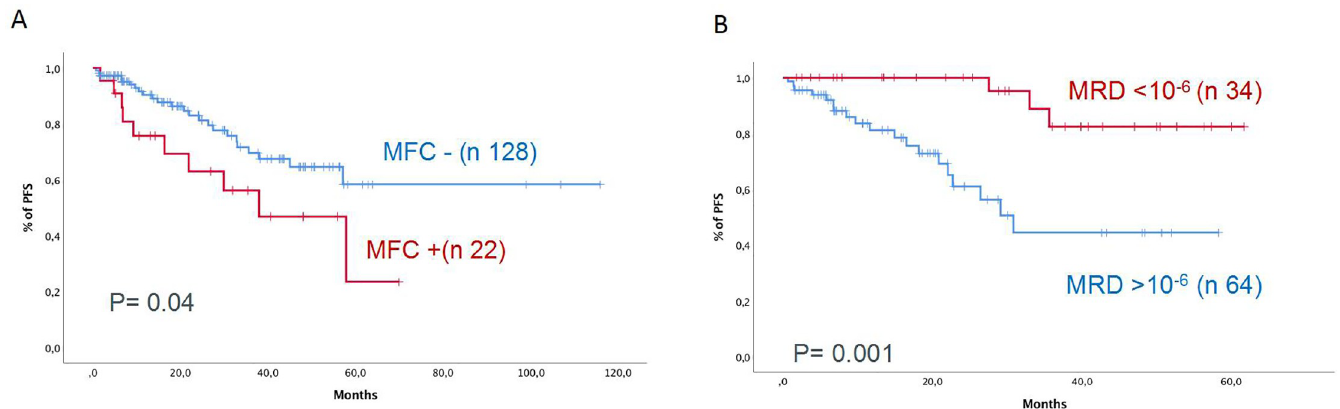
Fig 2. Progression-free survival of patients with stringent complete response classified by multiparametric flow cytometry (MFC) (A) and next-generation sequencing (NGS) results (B).